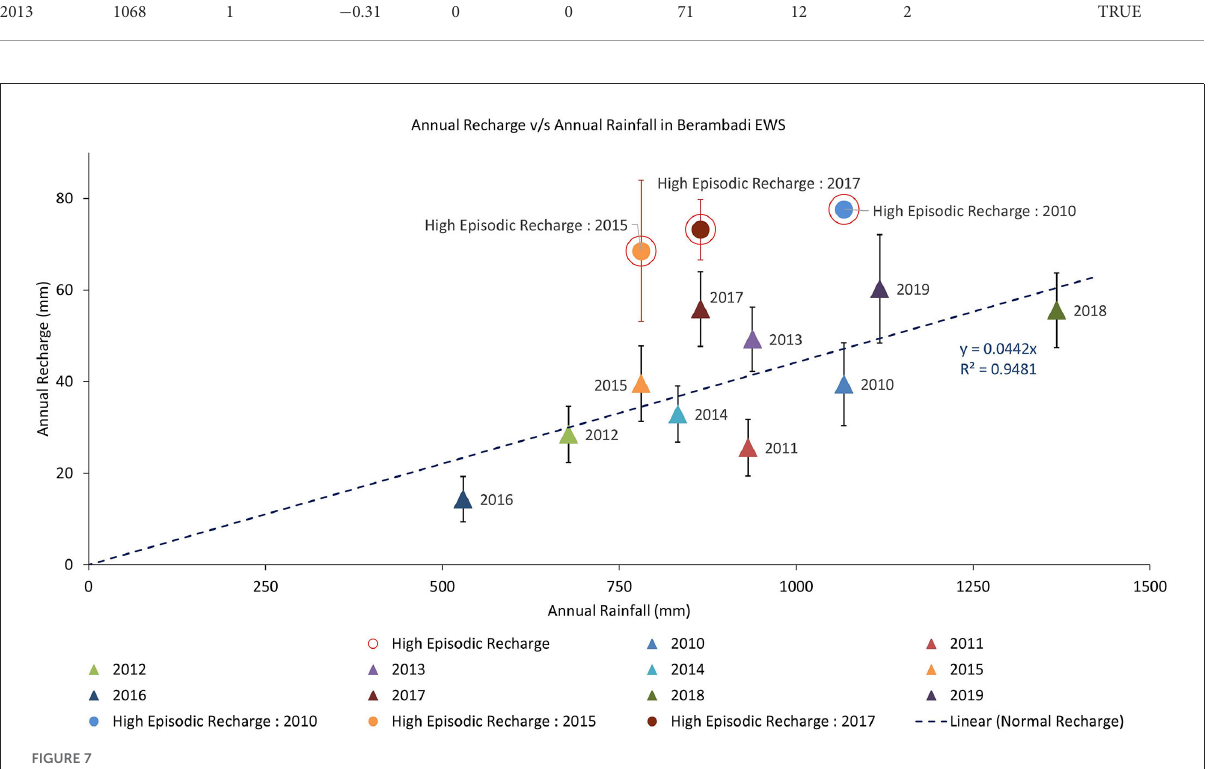
recharge factors for the year 2017 (8.1%) and 2019 (5.5%). A significant deviation from the observed groundwater level is detected in Case-1 simulations from 2017 onwards (RMSE = 3.9m). Case-2 simulations are able to capture the